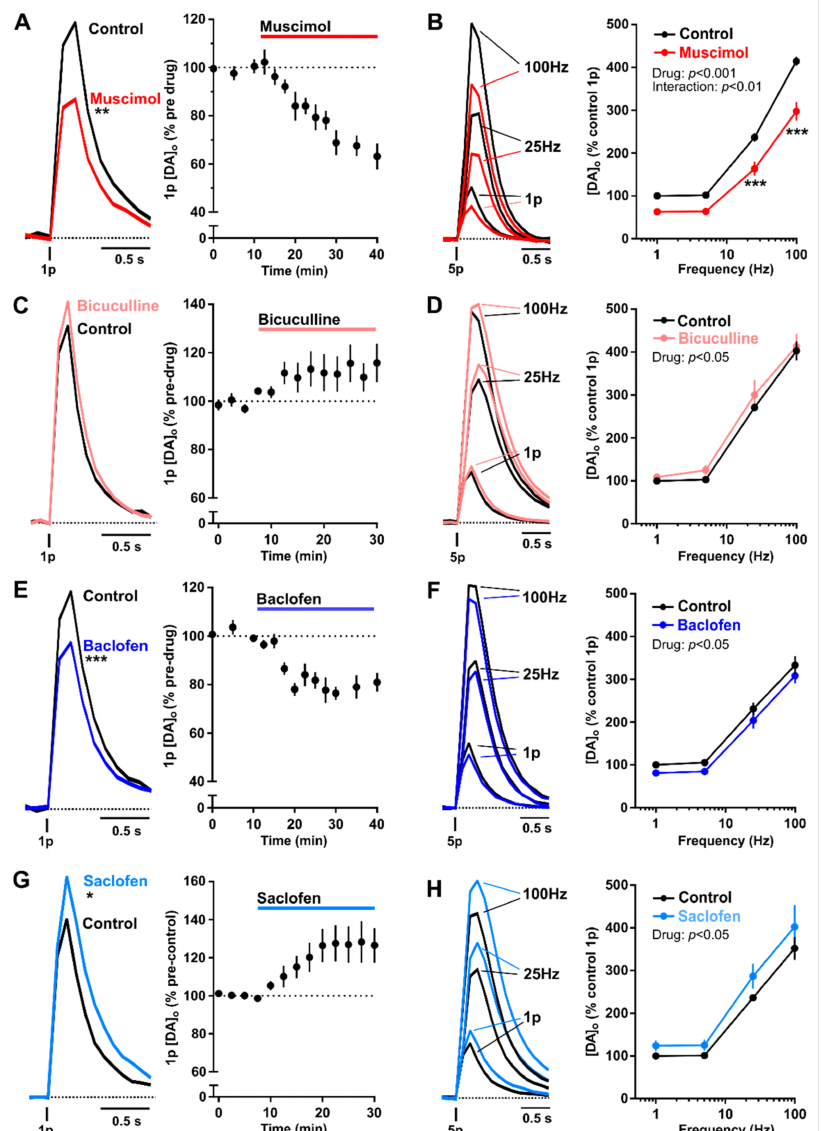
Figure 1. Modulation of striatal DA release in dorsal striatum by GABA A and GABA B receptor agonists and antagonists. ( A , C , E , G )—Mean [DA] o transients (left) and mean peak [DA] o ( ± SEM) versus time (right) evoked by 1 electrical pulse (1p) in dorsal striatum in the absence (control) and presence of GABA A agonist muscimol (20 µ M) ( A ), GABA A antagonist bicuculline (10 µ M) ( C ), GABA B agonist baclofen (10 µ M) ( E ), or GABA B antagonist saclofen (100 µ M) (G). ( B , D , F , H )— Mean [DA] o transients (left) and mean peak [DA] o ( ± SEM) conditions in the absence (control) and presence of GABA A agonist muscimol (20 µ M) ( B ), GABA A antagonist bicuculline (10 µ M) ( D ), GABA B agonist baclofen (10 µ M) ( F ), or GABA B antagonist saclofen (100 µ M) ( H ). All data were acquired in the presence of nAChR antagonist DH β E (1 µ M). * p ≤ 0.05, ** p ≤ 0.01, *** p ≤ 0.001, Mann-Whitney U test ( A , C , E , G ), Two-way repeated measure ANOVA ( B , D , F , H ). Figure adapted from